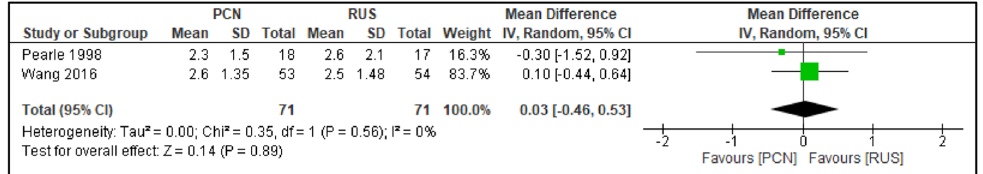
Figure 5. Comparison between PCN and RUS for outcome duration to defervescence.